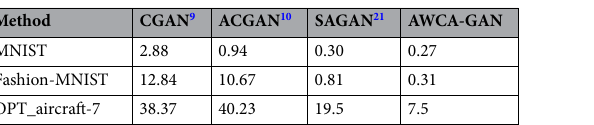
Table 1. Evaluation of FID values on MNIST, Fashion-MNIST, and OPT_aircraft-7.